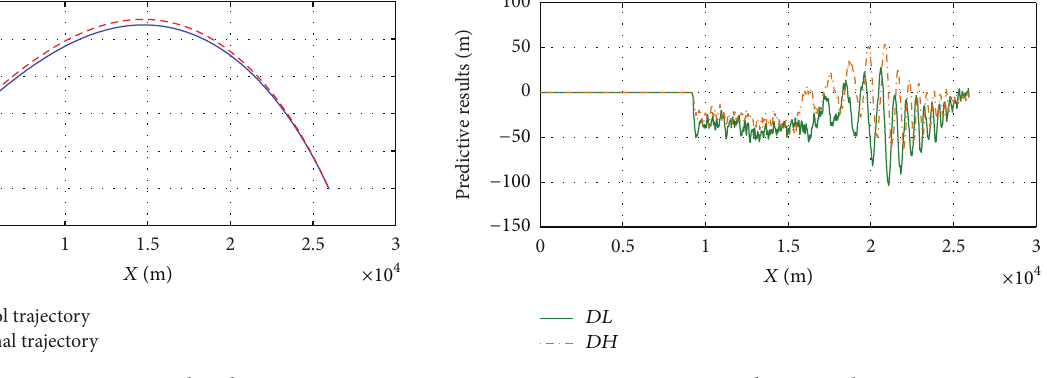
Figure 15: Range versus altitude.